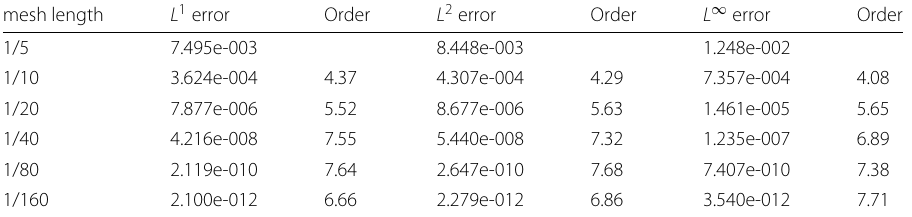
Table 3 1-D accuracy test: errors and convergence orders of 6th-order compact nonlinear schemes with (cid:10) t = 0.3 (cid:10) x 3 /